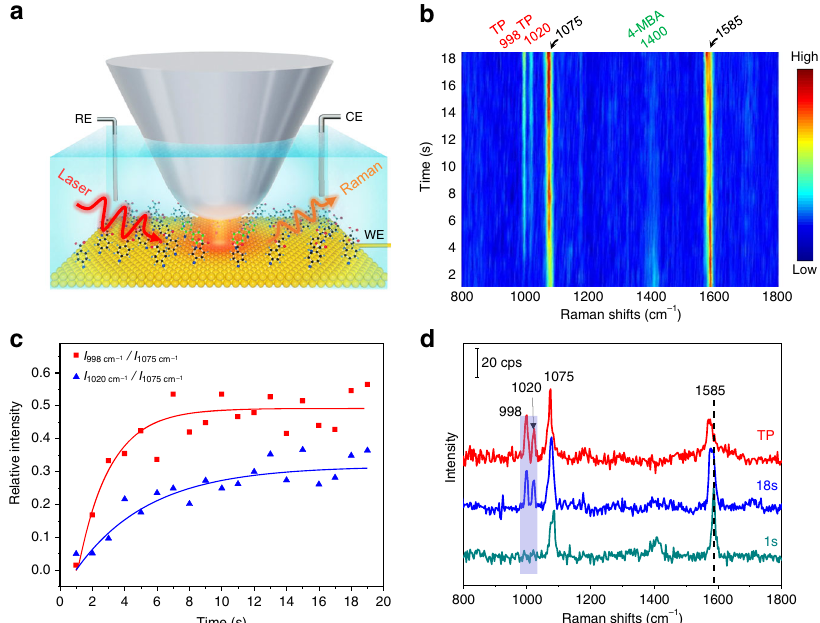
Fig. 1 Monitoring the decarboxylation of 4-MBA on Au(111). a Schematic illustration of the EC-TERS setup, where the decarboxylation reaction is induced by the strongly coupled SP between the Ag tip and Au substrate. b Time series TERS spectra of 4-MBA in 0.1 M NaClO 4 (pH 10). Power: 1.1 mW, bias: 200 mV, I tunneling : 800 pA, and E sample : − 0.32 V. c Plots of the relative intensities of the bands at 998 and 1020 cm − 1 (assigned to TP) to that at 1075 cm − 1 (combined contribution of TP and 4-MBA) against time. d TERS spectra of 4-MBA (at 1 and 18 s) and